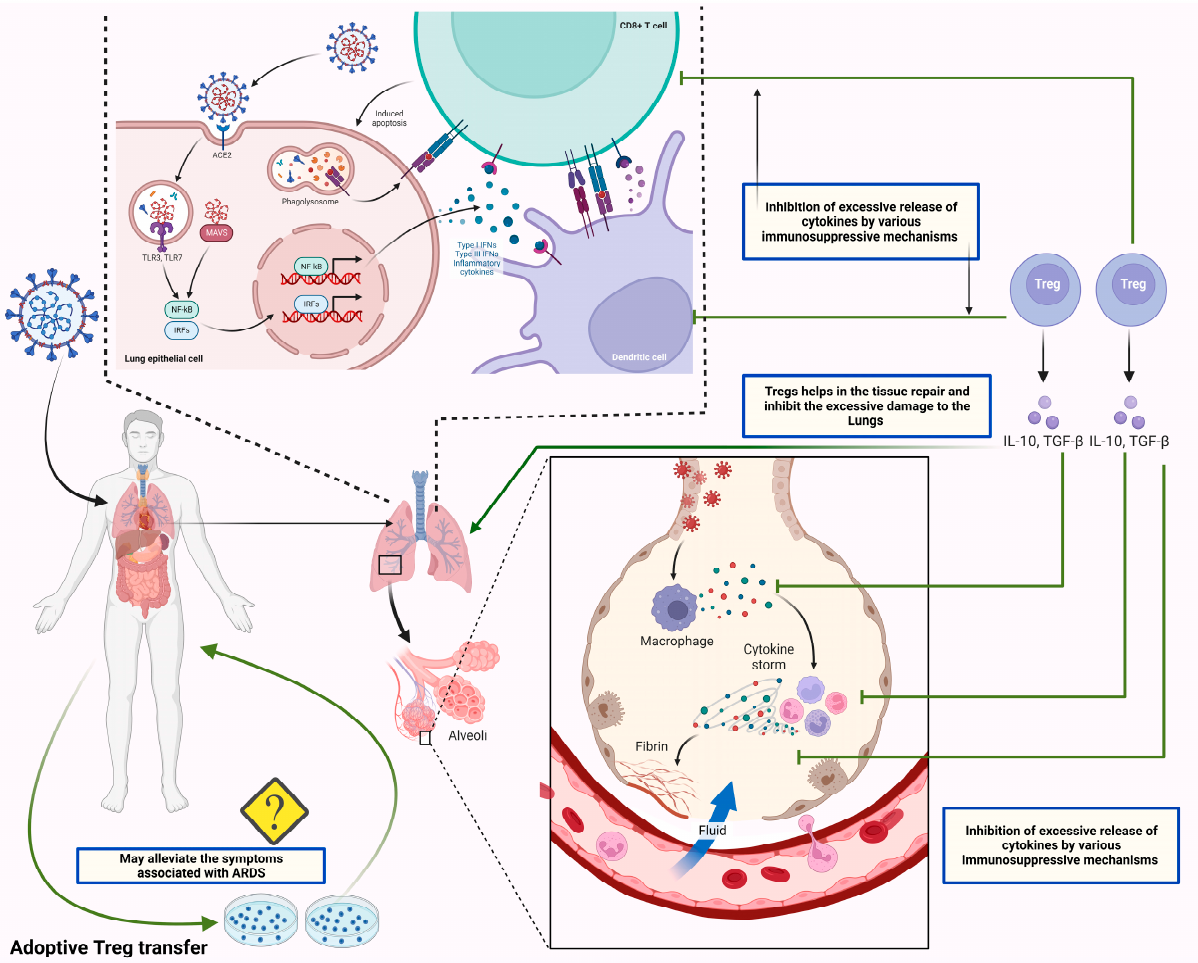
Figure 4. The figure shows the therapeutic potential of Tregs by suppressing the exaggerated immune response. SARS-CoV-2 infects the lung epithelial cells by entering through ACE2 receptors. SARS- CoV-2 infects lung epithelial cells by using ACE2 receptors. As viral RNA enters the cell, it activates endosomal and cytoplasmic sensors, including TLR3/7 and MAVS. Further, these endosomal and cytoplasmic receptors activate IRFs and NFkB, resulting in the production of inflammatory cytokines such as interferons (IFN). Dendritic cells acquire antigen before migrating to lymphoid organs to activate adaptive immunity. Following the recognition of antigens on antigen-presenting cells (APCs) or infected cells, CD8 T lymphocytes trigger apoptosis. Additionally, the viral antigens present to the T cells through antigen processing. Antigen processing is the process through which APCs, such as dendritic cells and alveolar macrophages, endocytose and kill the SARS-CoV-2 virus. MHC proteins then express antigen fragments on the cell membrane, enabling T lymphocytes to identify them. The overstimulated T cells and APCs in severely infected patients lead to excessive secretion of cytokines/chemokines, which leads to lung damage and ARDS. The balanced concentration of Tregs can suppress the exaggerated immune response through its immunoregulatory and immunosuppres- sive activities. In this context, recent studies suggested the beneficial effects of the adoptive transfer of Tregs in severely infected patients, which is yet to be approved for its clinical